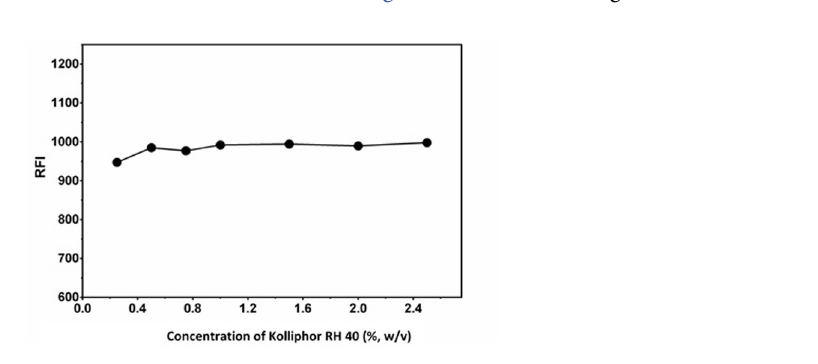
Fig 3. Effect of concentration of kolliphor RH 40 on the RFI values of its interaction mixture with LAP (1000 ng/ mL).